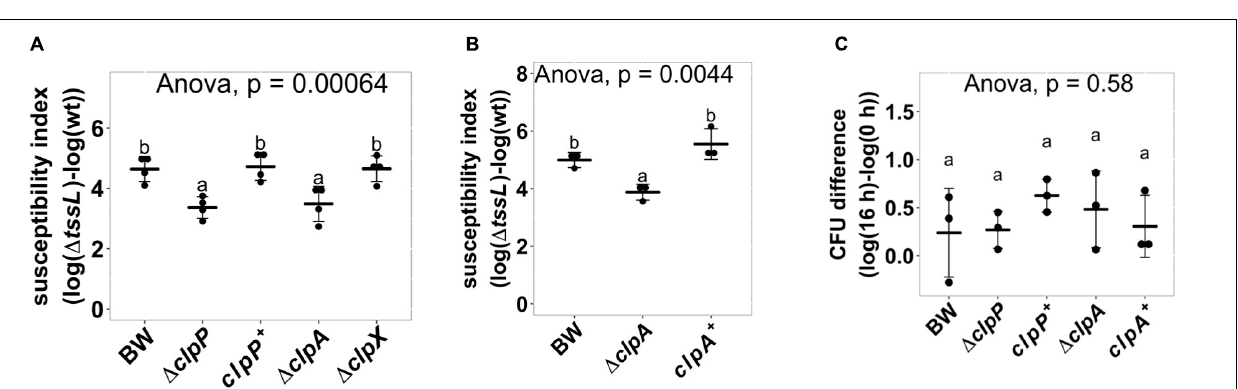
FIGURE 5 | Protease activity assay of the ClpP and its catalytic variants. The wild-type ClpP and its catalytic variants were each pre-assembled with ClpX followed by providing its substrate, the ssrA-tagged green fluorescent protein (GFP). The GFP fluorescent signals were monitored (A) over time, and (B) statistical analysis was measured at the end of the assay. Statistical analysis involved single-factor analysis of variance (ANOVA) and Tukey honestly significant difference (HSD) with P < 0.05 for statistical significance. Two groups with significant differences are indicated with different letters (a and b). Data are mean ± SD of three biological replicates from one representative result of at least two independent experiments.